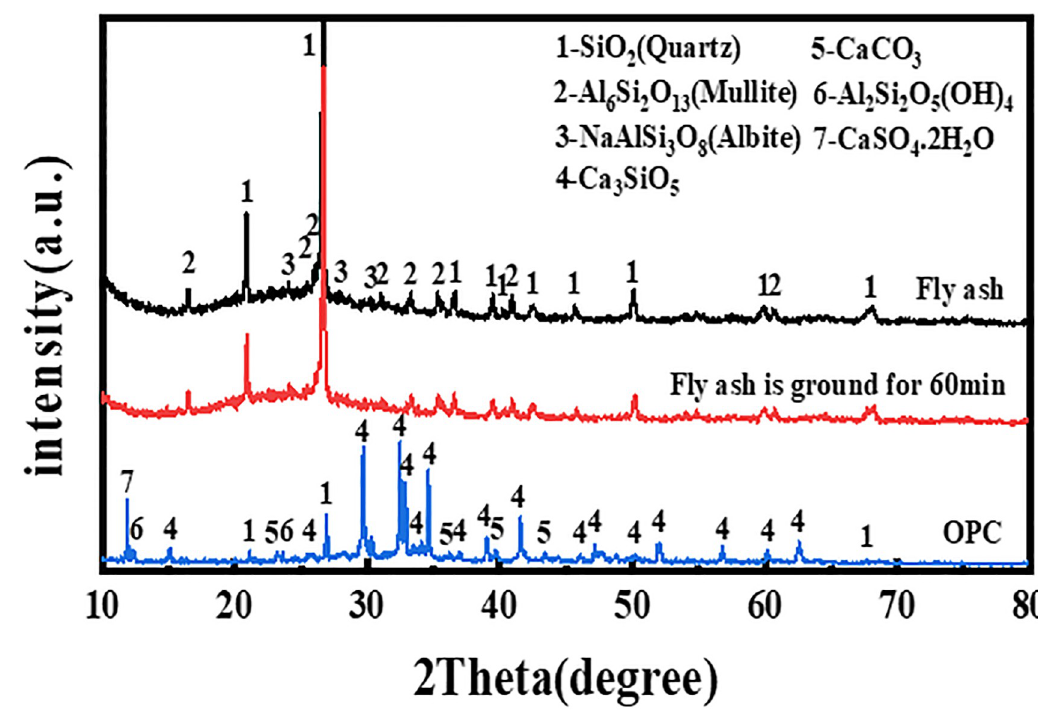
Fig 1. XRD patterns of the raw materials.